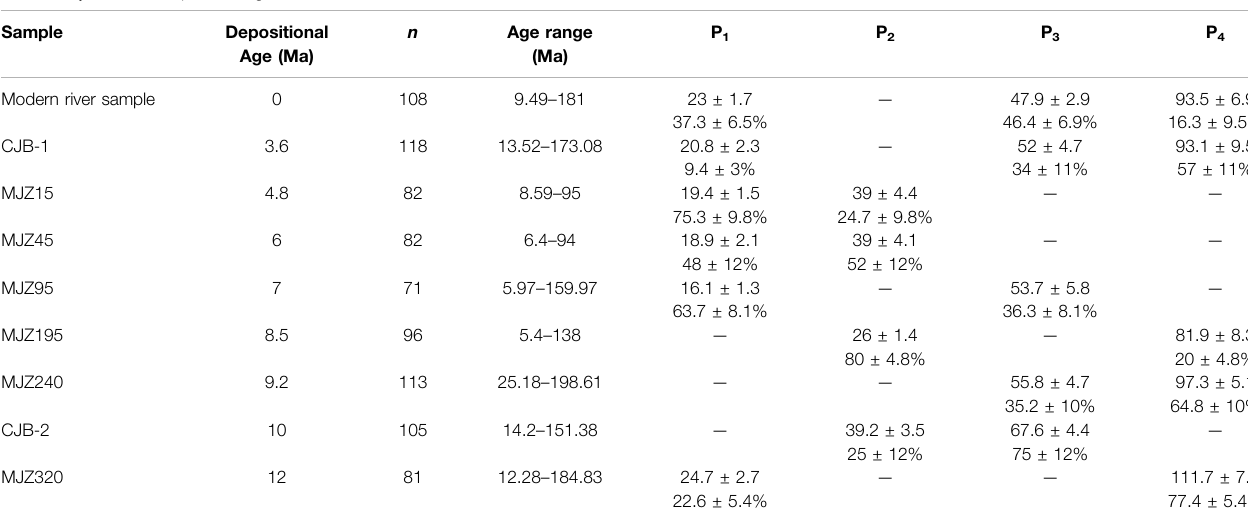
TABLE 2 | Detrital AFT peak- fi tting data.